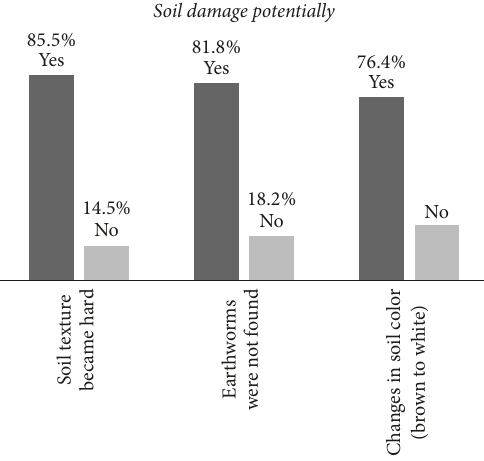
Figure 1: Degradation potential of soil